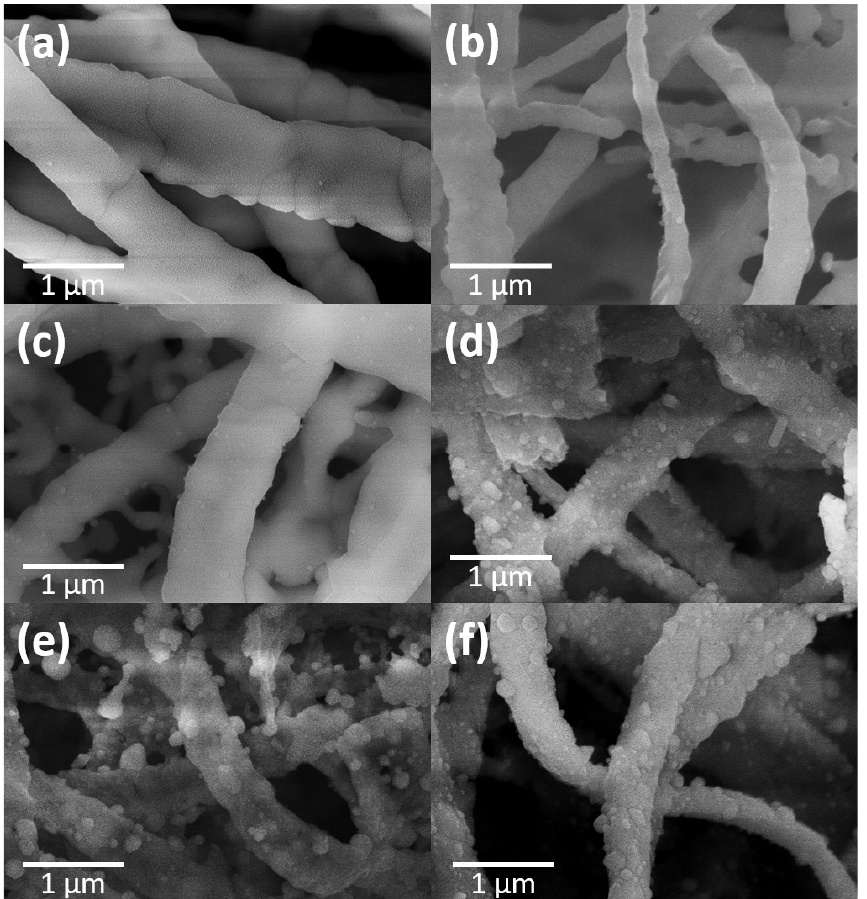
Figure 13. SEM images of CuYO 2 nanofibers after MSR at different temperatures ( a ) 250 °C, ( b ) 300 °C, ( c ) 350 °C, ( d ) 400 °C, ( e ) 450C and ( f ) 500 °C.